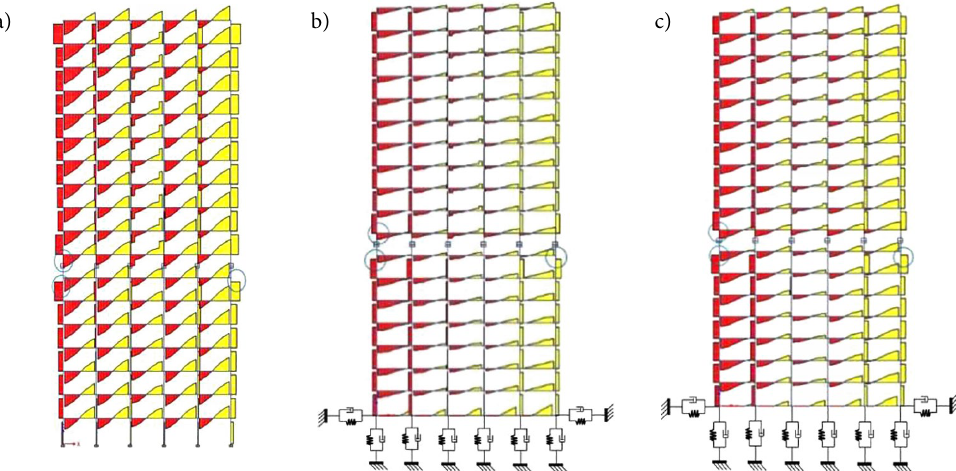
Figure 12. Shear force comparison of frame: a – shear force of frame without considering the SSI effect; b – shear force of frame considering SSI effect (hard soil); c – shear force of frame considering SSI effect (soft soil)